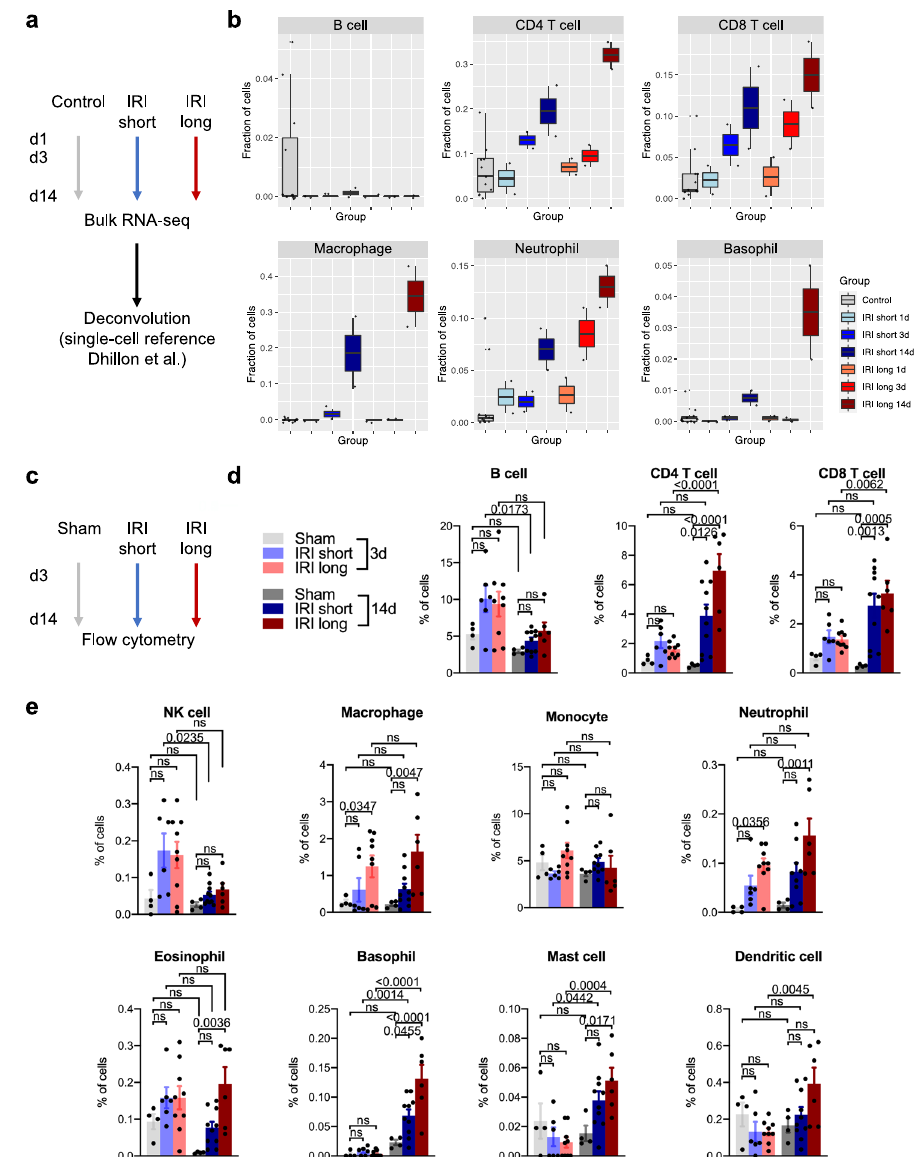
Fig. 2 Bulk deconvolution and fl ow cytometry con fi rm lymphoid and myeloid cell in fi ltration in maladapted kidneys. a Kidney bulk RNA-seq data were in silico deconvoluted using a previously published kidney single cell reference that is known to be rich in heterogeneous immune cell populations (Dhillon et al.). b Quanti fi cation of cell fractions after bulk RNA-seq deconvolution, displayed as Tukey box plots. c Flow cytometry was performed in an independent set of experiments; the gating strategy is shown in Fig. S6. d , e Flow cytometry quanti fi cation of lymphoid ( d ) and myeloid ( e ) cells representing n = 4 independent experiments. Increasing doses of ischemic injury resulted in signi fi cant increases in lymphoid and myeloid cell in fi ltration; means ± SEM; p values for one-way ANOVA (Holm – Sidak corrected); light coloring in bar graphs denotes 3 d time points, full coloring denotes 14 d time points; NK, natural